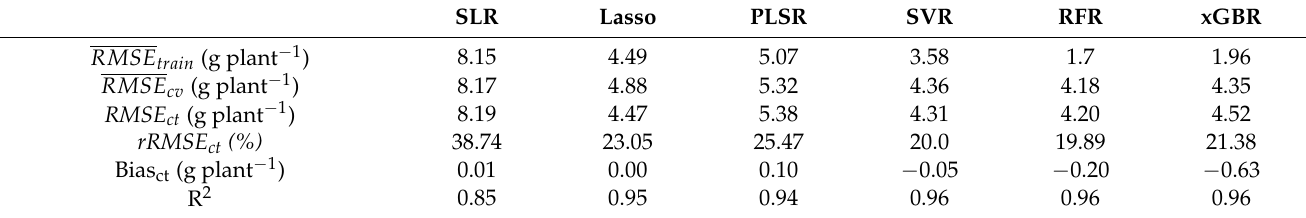
Table A1. Model training performance using randomized Kfold-CV for the prediction of the leek DBM using the data from the 2019